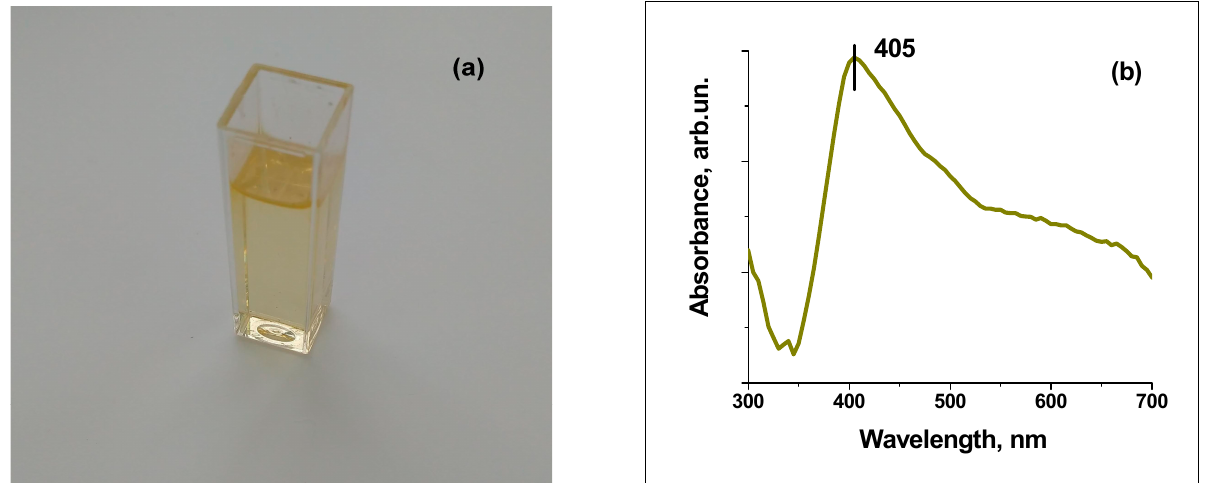
Figure 2. ( a ) Typical photo of Ag-contained sol after dissolution Ag/ γ -Al 2 O 3 sample. ( b ) UV–visible spectra of Ag-contained sol (right).